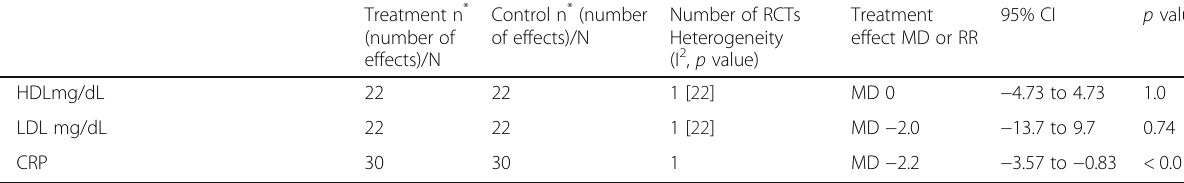
Table 2 Inositol for reproduction, hyperandrogenism, metabolism, anthropometry and risk factors (Continued) Treatment n * (number of